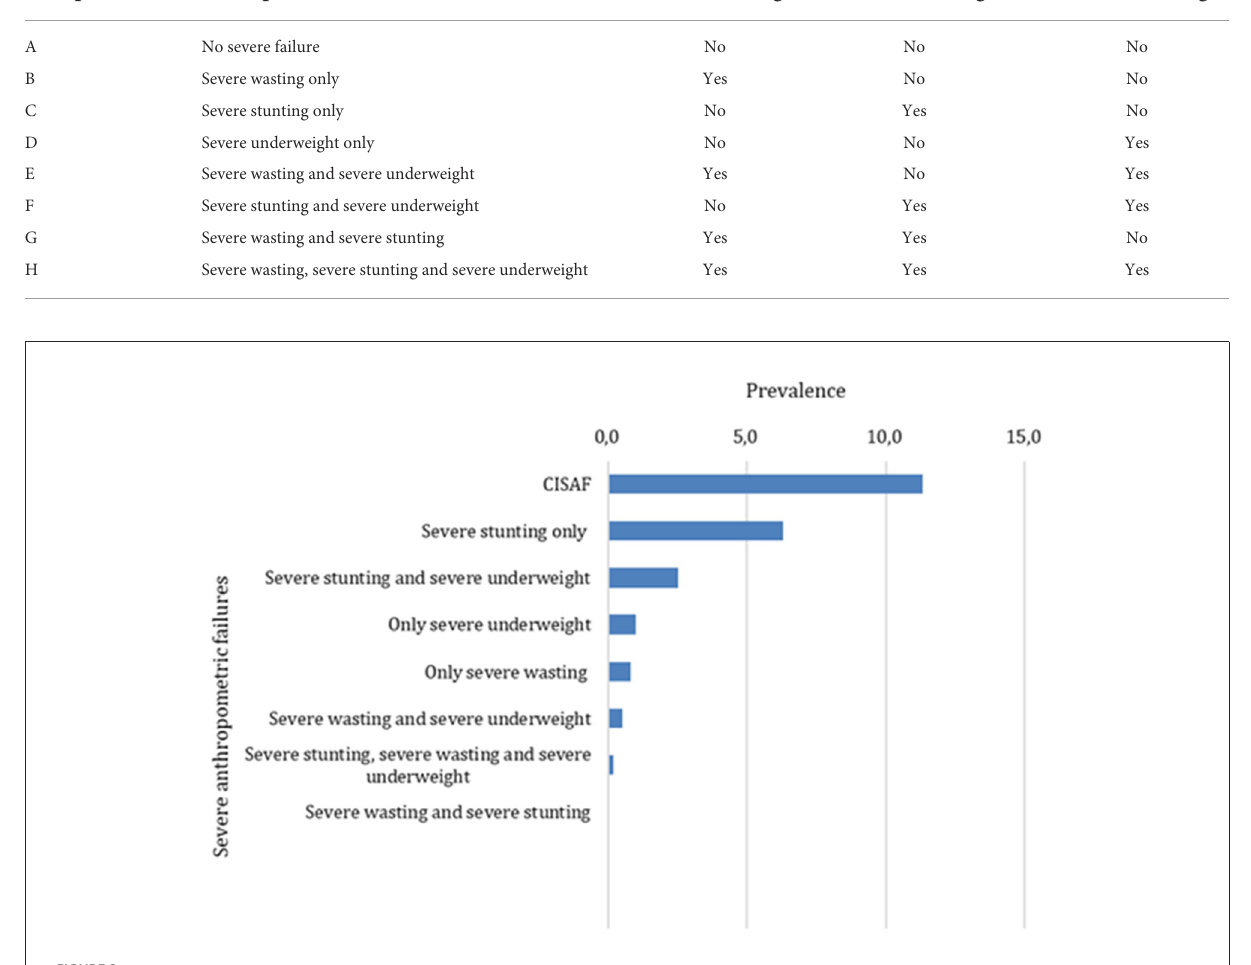
FIGURE2 Prevalence of under-5